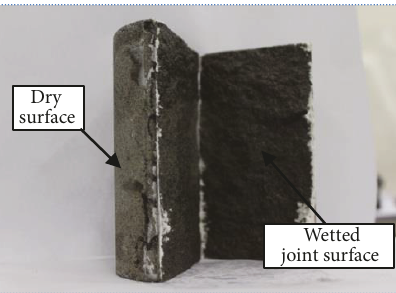
Figure 4: Surface characteristics of unidirectional fi ssure